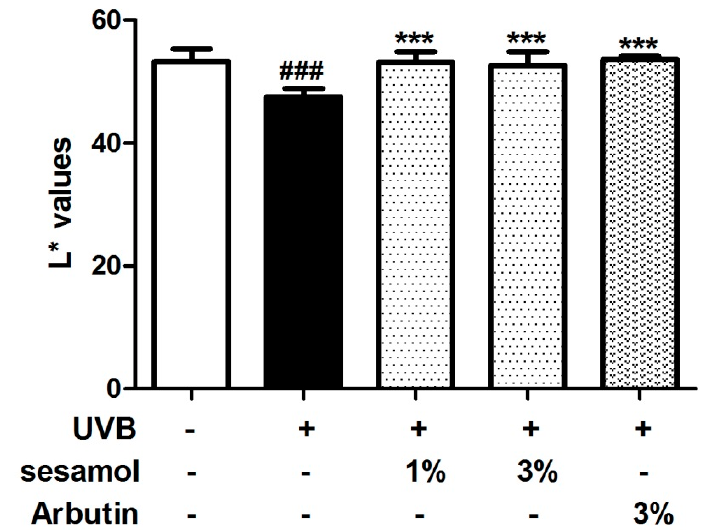
Figure 4. Effect of sesamol on L* values (brightness) of C57BL/6 mouse ear skin after UVB irradiation in the fourth week. UVB irradiation decreased L* values, whereas topical application of sesamol increased L* values. (Significant difference versus control: ###, p < 0.001. Significant difference versus UVB treated group: ***, p < 0.001.).